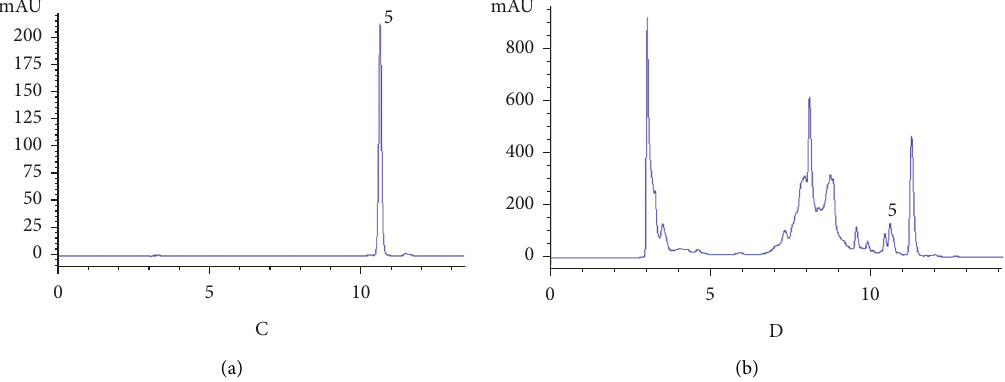
Figure 3: RP-HPLC chromatogram of rutin (note: C and D are reference substances; 5,